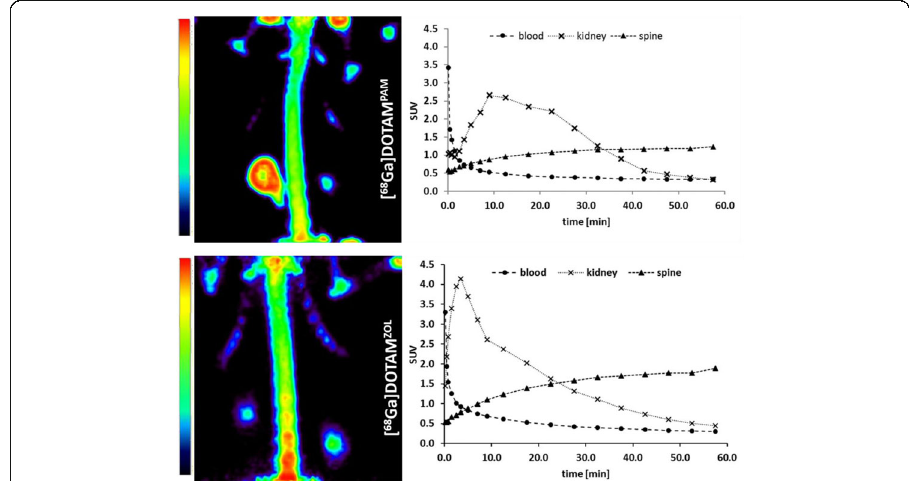
Fig. 3 MIP (maximum intensity projection) in the thorax region of Wistar rats after 60 min p.i. and time activity curves (TAC) of [ 68 Ga]DOTA PAM and [ 68 Ga]DOTA